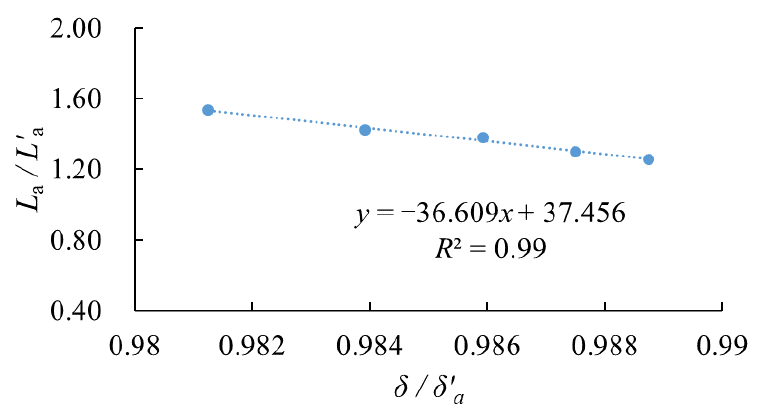
Figure 19. The relationship between L a / L (cid:48) a and δ / δ (cid:48) a when groin B is in the upstream far-field of groin